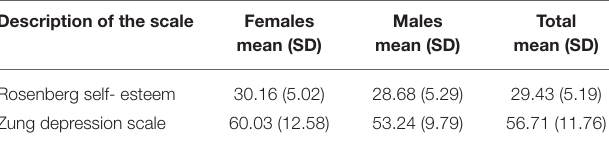
TABLE 2 | Descriptive analysis of RSES scale and ZSDS scale, and gender-wise comparison between levels of self-esteem and depression based on Rosenberg’s classifications and Zung’s depression index